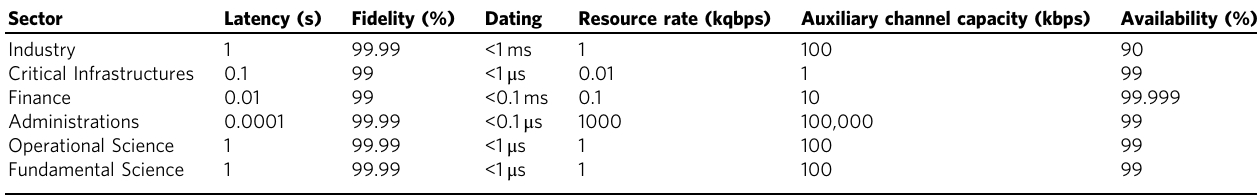
Table 1 Estimated order of magnitude for the main key performance indicators (KPIs) of a